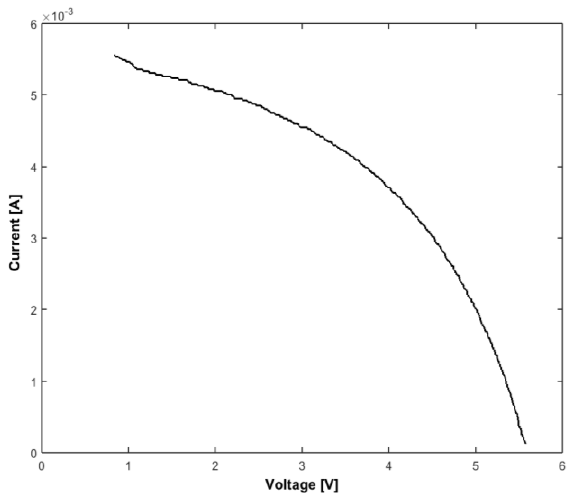
Figure 4 . Obtained I-V curve from experimental data.